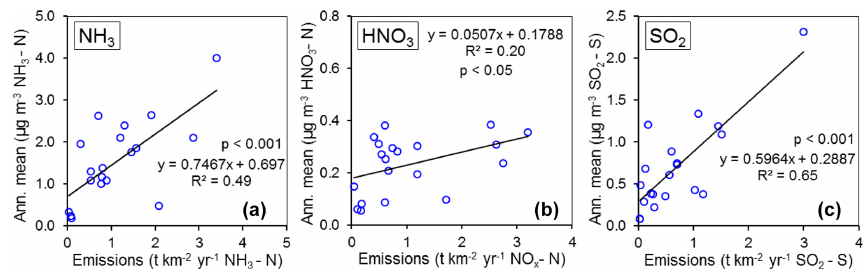
Figure 10. Regression plots of national annual averaged gas (NH 3 , HNO 3 , SO 2 ) concentrations (2007–2010) vs. 4-year national averaged emission densities of respective gases (NH 3 , NO x , and SO 2 : tkm − 2 yr − 1 ) from each country over the same period ( n = 20). Table 3. Summary statistics of regression analyses between national annual averaged gas (NH 3 , HNO 3 , SO 2 ) and aerosol (NH + ) concentrations and national emission densities (4-year average for period 2007 to 2010, expressed as emissions per unit area of the SO 2 − 4 country per year) for each of the 20 countries in the NEU DELTA ®